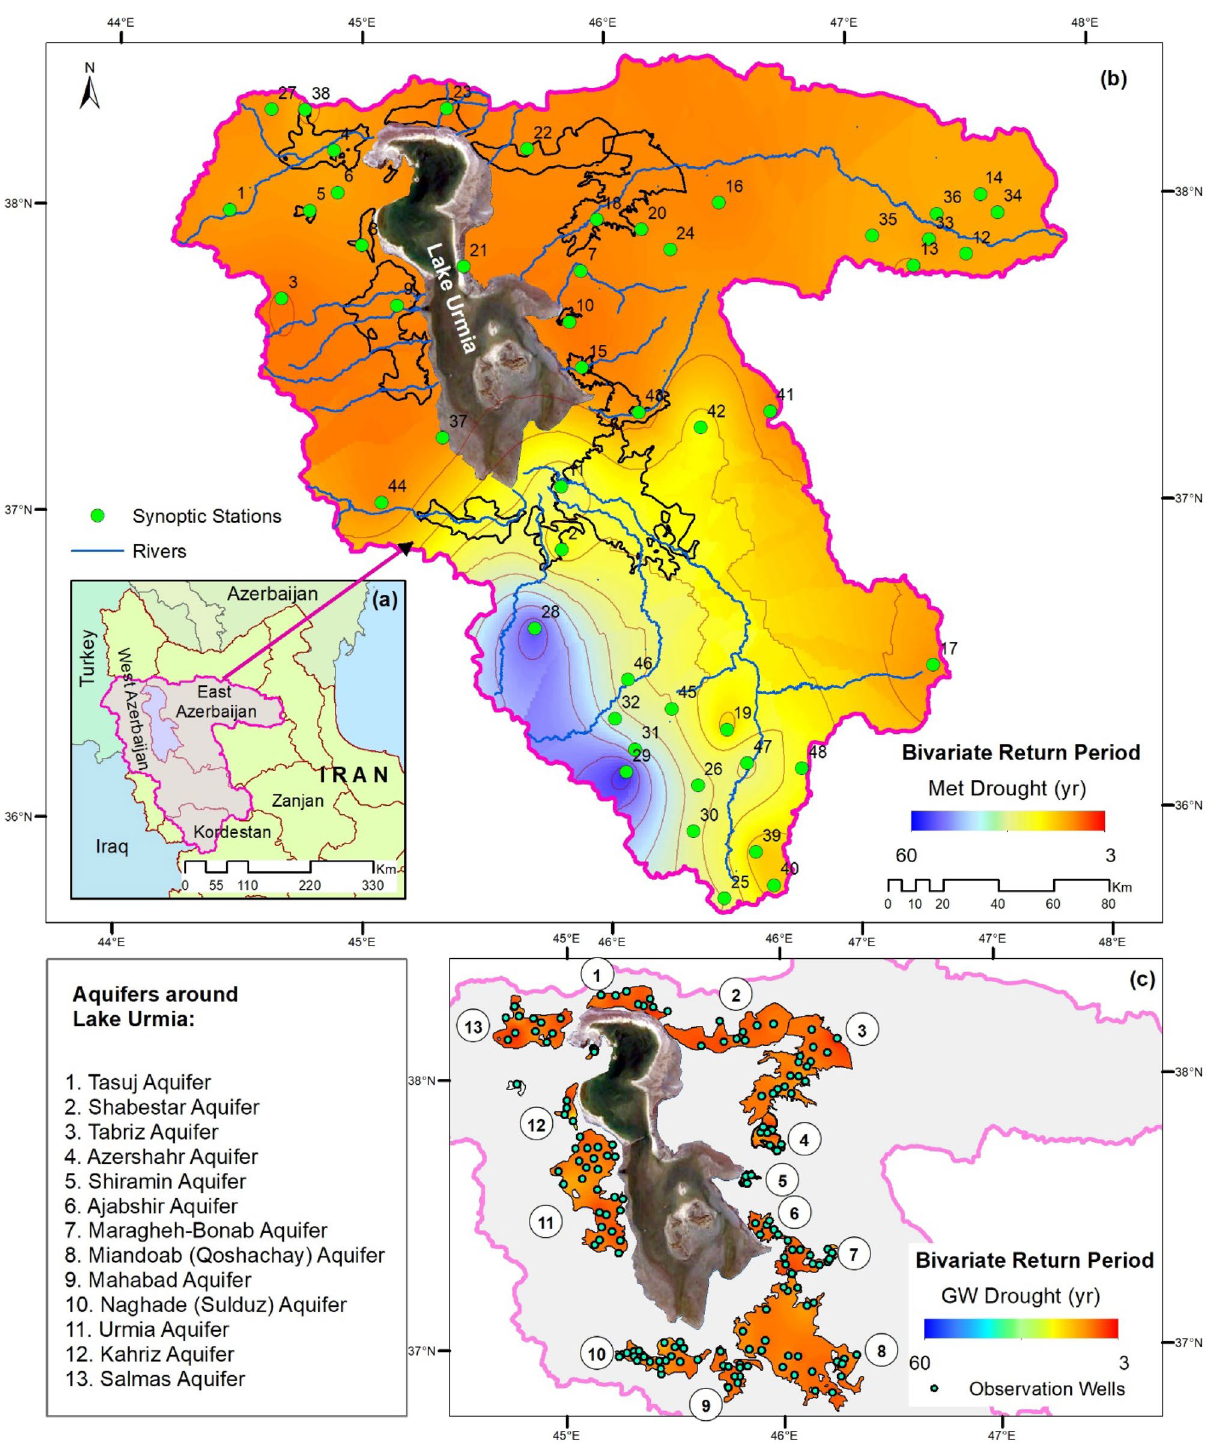
Figure 4. ( a ) Location map of the study area; ( b ) spatial distribution of Met drought return period within the Lake Urmia basin; and ( c ) spatial distribution of GW drought return period within the aquifers around the lake. Note 1: The contours for each aquifer varies but not much and more often are lower (more severe) than those of Met droughts. Note: 2: The figure is produced by the authors using QGIS 3.01 v